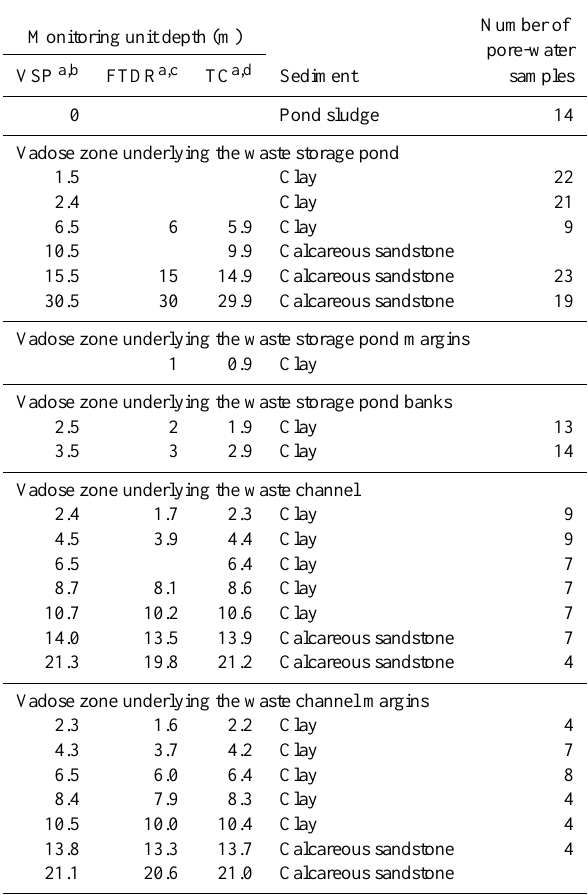
Table 1. The monitoring setup (modified from Baram et al.,